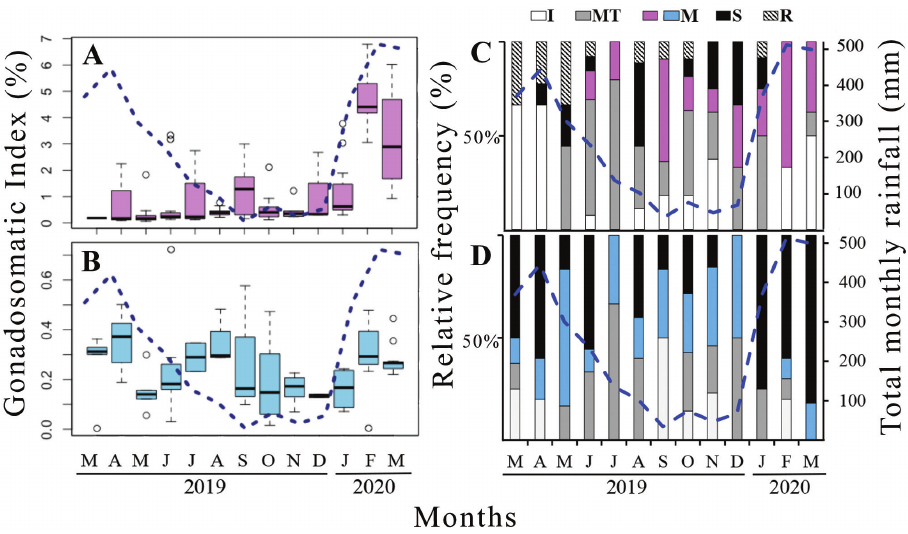
FIGURE 5 | Mean monthly Gonadosomatic Index (GSI) of ( A ) the females and ( B ) the males Helogenes marmoratus compared with the relative frequency of the different gonadal development phases: I: immature, MT: maturing, M: mature, S: spawned/spent, R: repousing of ( C ) the females and ( D ) the males collected in a catchment of Guamá River in Capitão Poço, Pará State, Brazil, between March 2019 and March 2020. The dashed blue line represents the total monthly